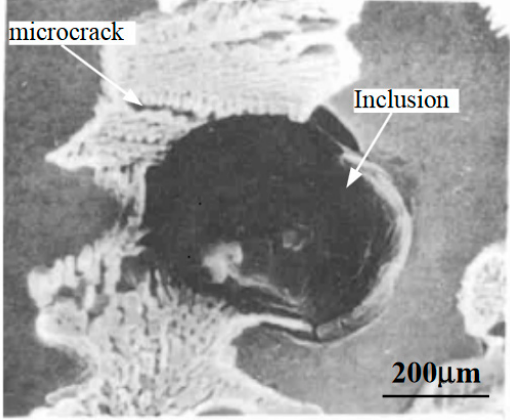
Figure 3. SEM micrograph of Fe 55 Cr 20 Ni 10 B 2 Si 2 laser cladding coating.